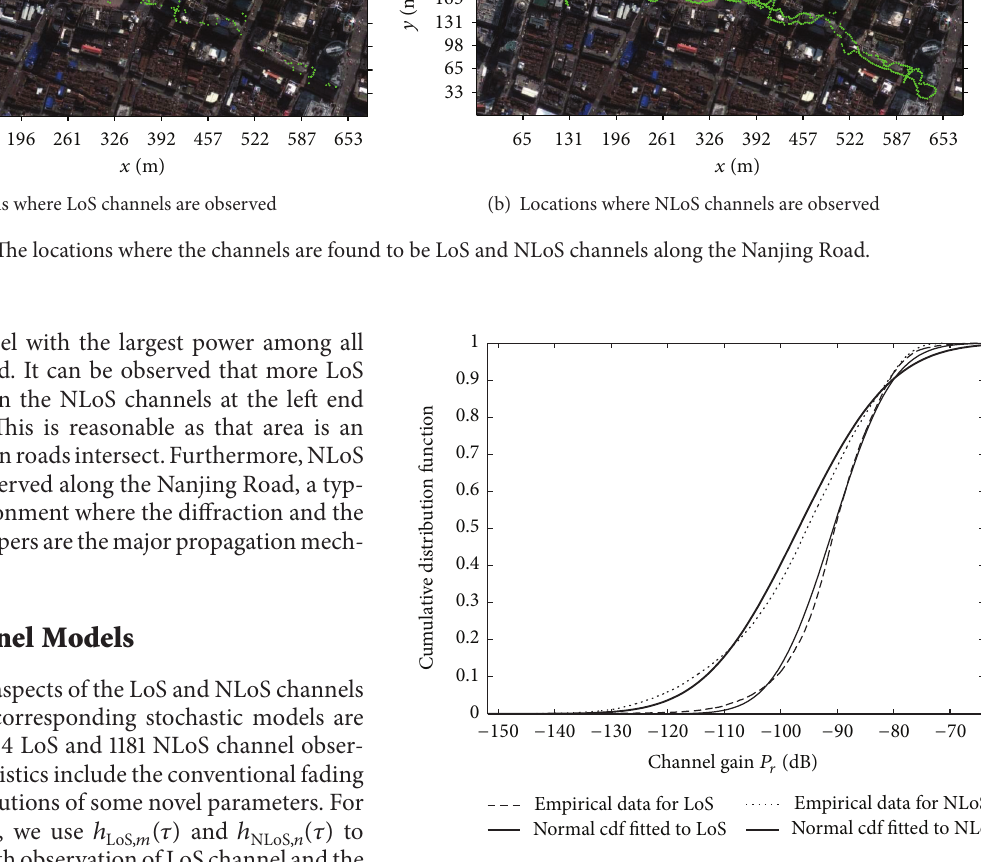
Figure 6: The empirical and fitted cdfs of the channel gains in the LoS and NLoS scenarios. Table 1: Parameters of analytical pdfs fitted to the empirical